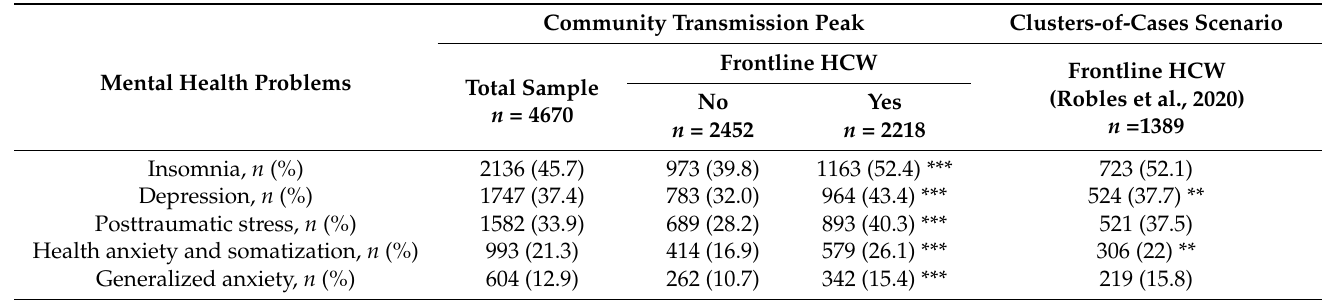
Table 2. Mental health problems.